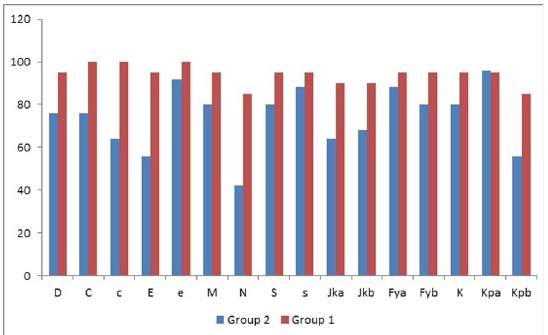
Fig 5. Frequency of identical results of phenotyping and genotyping of each studied non-ABO- erythrocyte antigen among the studied Mediterranean hemopathic syndromes patients’ groups.